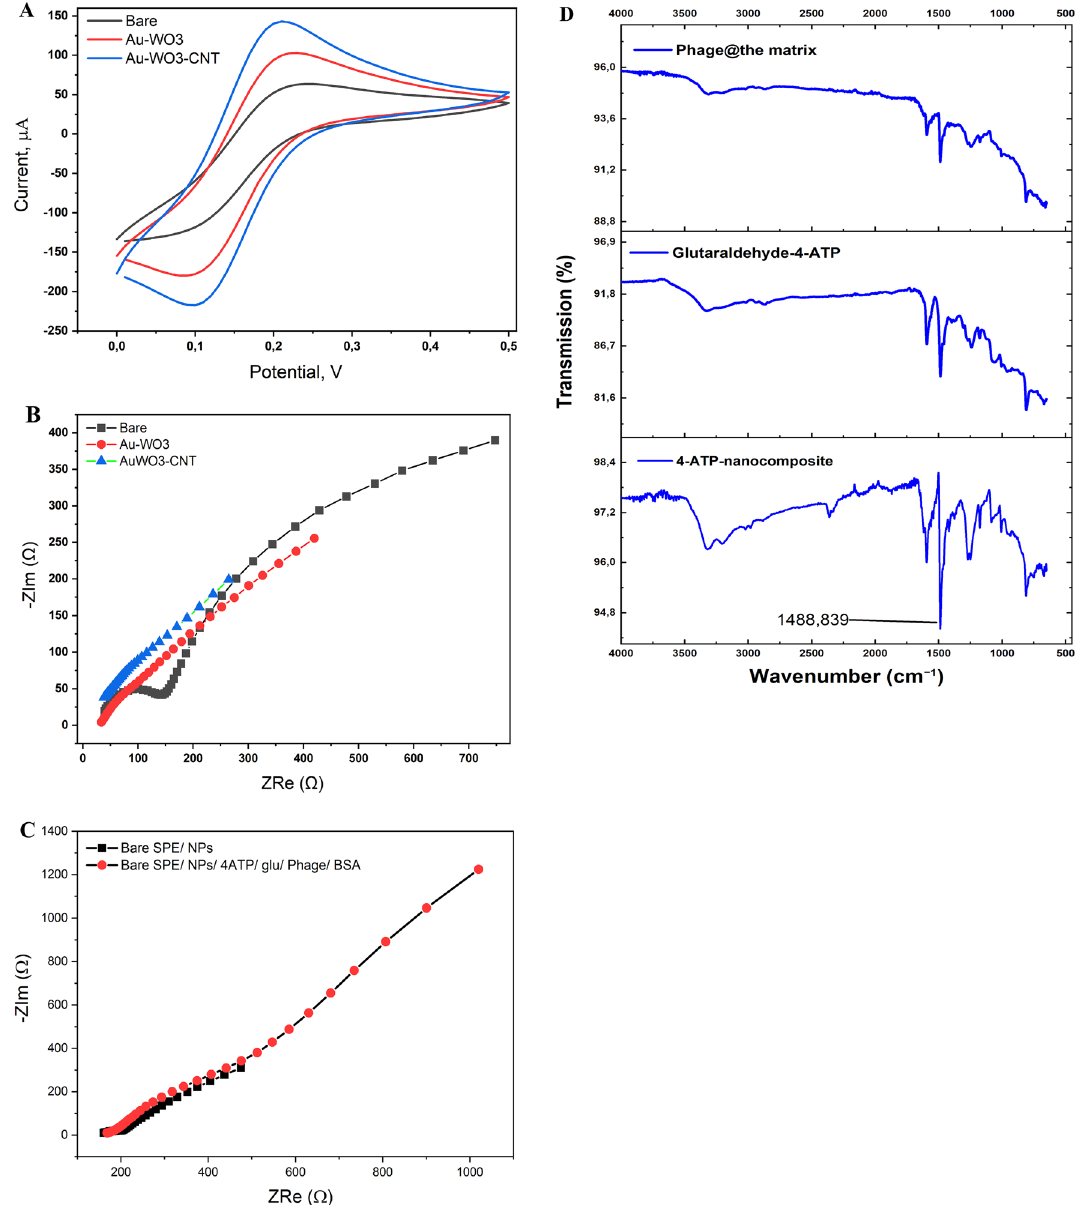
Figure 2. ( A ) Cyclic voltammetric responses of electrode surfaces towards the redox reactions of Ferricyanide (FCN, 5 mM) as the standard redox probe. ( B ) Impedimetric responses of electrode surfaces towards the redox reaction of Ferricyanide (FCN, 5 mM) as the standard redox probe. ( C ) Impedimetric responses of electrode surfaces before and after the immobilization of the active bacteriophage. ( D ) FTIR spectra of the preparation steps of the phage-based